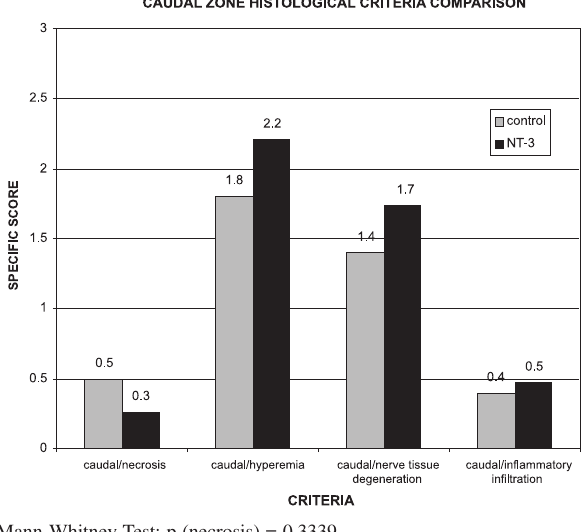
Mann-Whitney Test: p (necrosis) = 0.3339. Figure 6 - Comparison of Specific Scores in the Caudal Zone between Control and NT-3 Groups